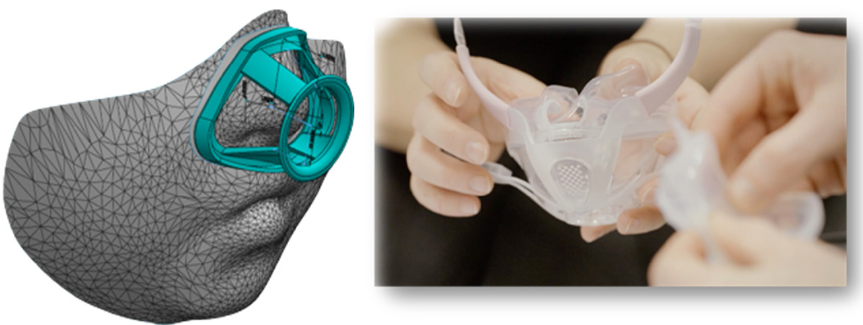
Figure 1. Facial mapping to develop a 3 dimensional model of a framework for a mask that will fit directly onto child’s face for non-invasive ventilation ( left ). 3D printed bespoke non-invasive ventilation mask ( right ) [8]. Pictures courtesy of Professor Heather Elphick, Sheffield Children’s NHS Foundation Trust UK .